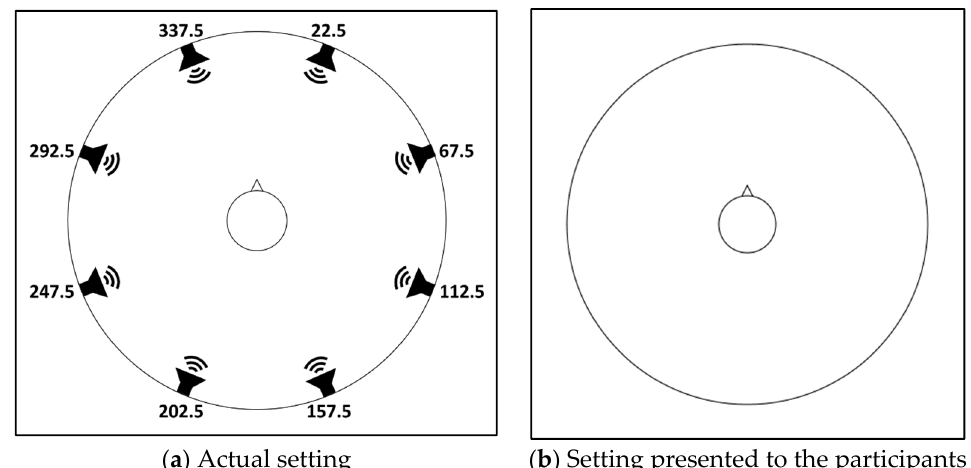
Figure 3. Experimental setting. The symbol in the middle represents participant orientation. ( a ) The actual setting: Participants sat in the middle of a circle of eight monitors separated by 45°, starting from 22.5° through 337.5°. ( b ) The setting presented to participants on a computer screen: participants were asked to indicate on the circle the location of the perceived sound source.